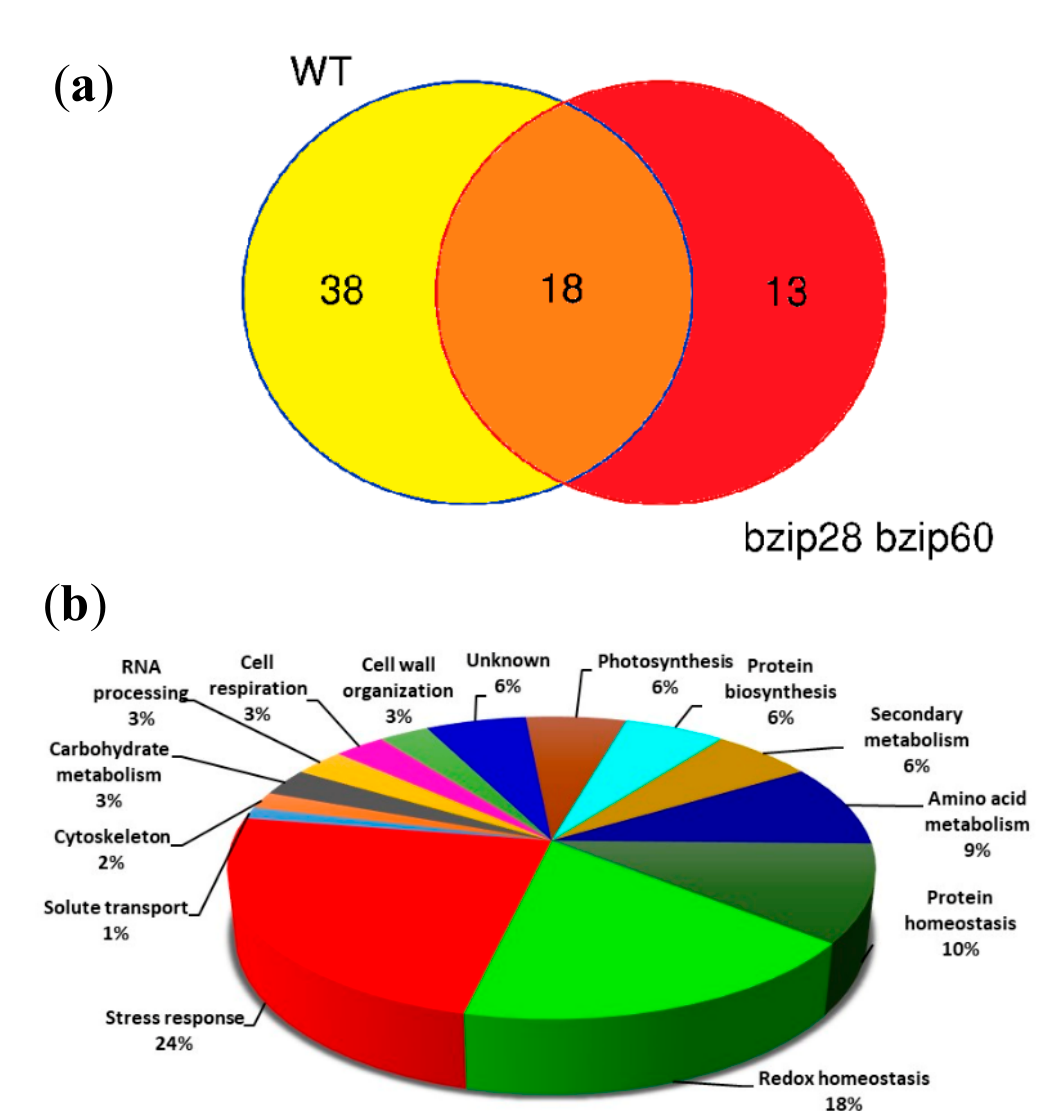
Figure 8. Differentially represented proteins in leaves from WT and bzip28 bzip60 mutant Arabidopsis plants infected or not by D. gigantea for 24 h. ( a ) Venn diagram showing common and specific differentially represented proteins between WT and bzip28 bzip60 mutant plants. ( b ) Functional classification of differentially represented proteins in leaves from WT and bzip28 bzip60 mutant Arabidopsis plants. An independent pairwise comparison of leaves of infected WT vs. non-infected WT plants, as well as of infected bzip28 bzip60 mutant vs. non-infected bzip28 bzip60 mutant plants was performed, as reported in the main text and Figure